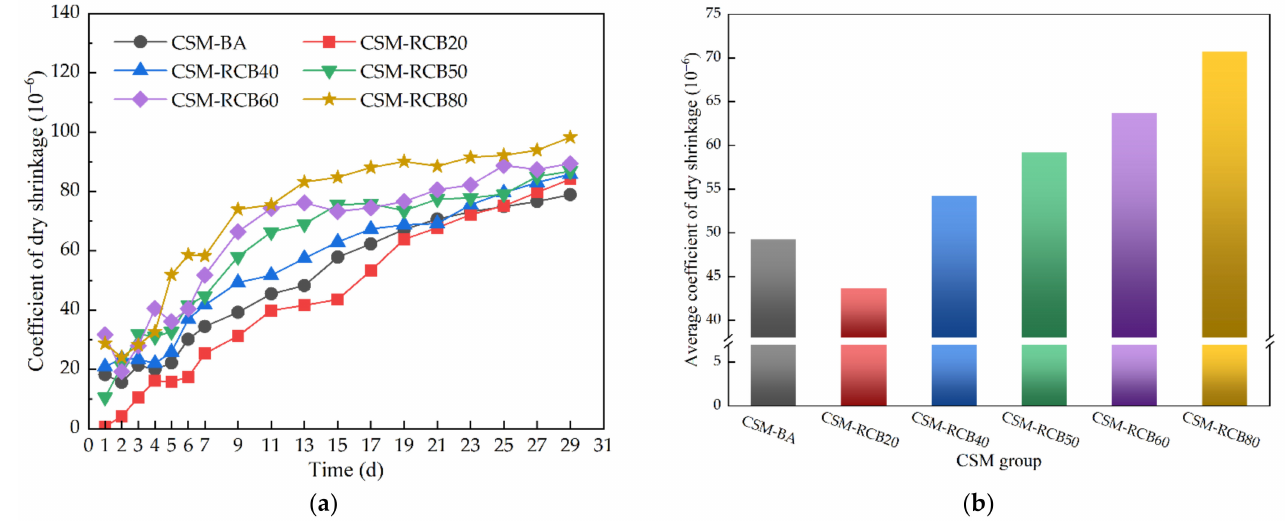
Figure 12. The coefficient of dry shrinkage: ( a ) coefficient of dry shrinkage with time; ( b ) average coefficient of dry